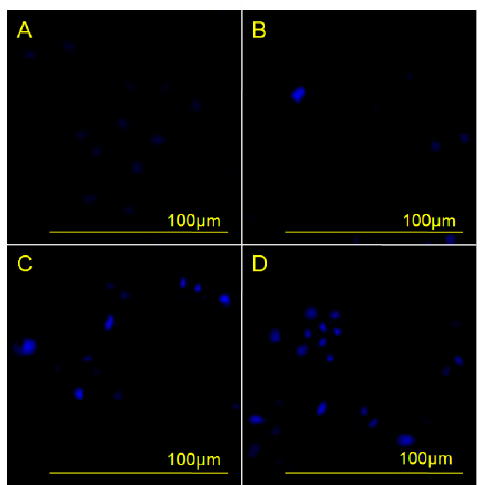
Figure 2. Effects of compound 3 on human cervical carcinoma HeLa cell apoptosis were observed by DAPI staining under an inversion fluorescent microscope. HeLa cells were incubated with 0 µM ( A ); 2.5 µM ( B ); 5 µM ( C ); or 10 µM ( D ) of compound 3 for 48 h.